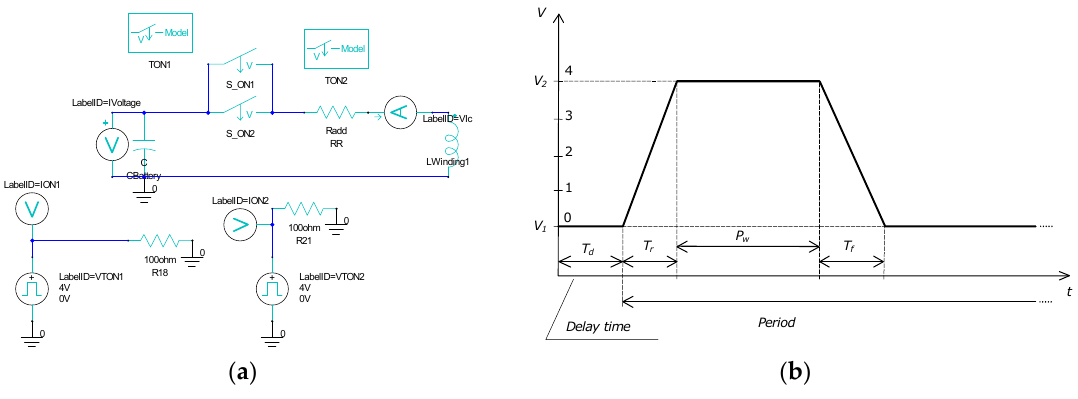
Figure 7. Modelling of the power supply of the drive coil ( a ) Outer circuit supplying of the coil ( b ) Shape of the trigger signal.